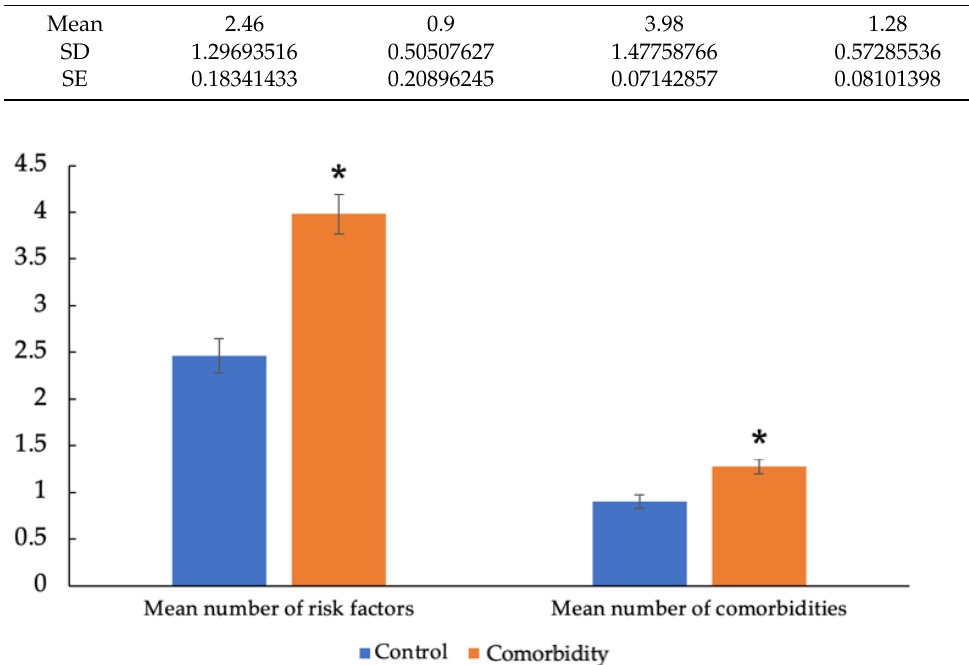
Figure 2. Mean number of risk factors and comorbidities compared to principal diagnosis. *: Indi ‐ cates significant difference between the standrad error of the means. significant difference between the standard error of the